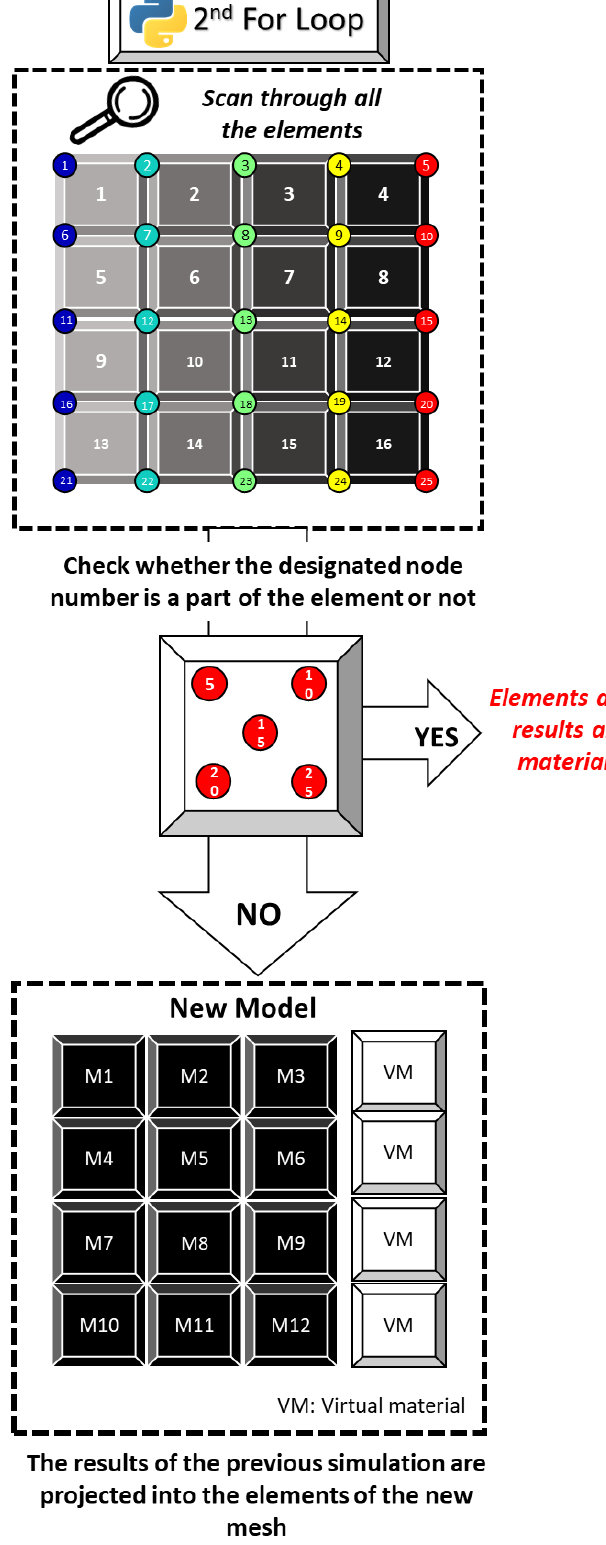
Figure 3. A simplified illustration of the second part of the code. Identifying the elements (out